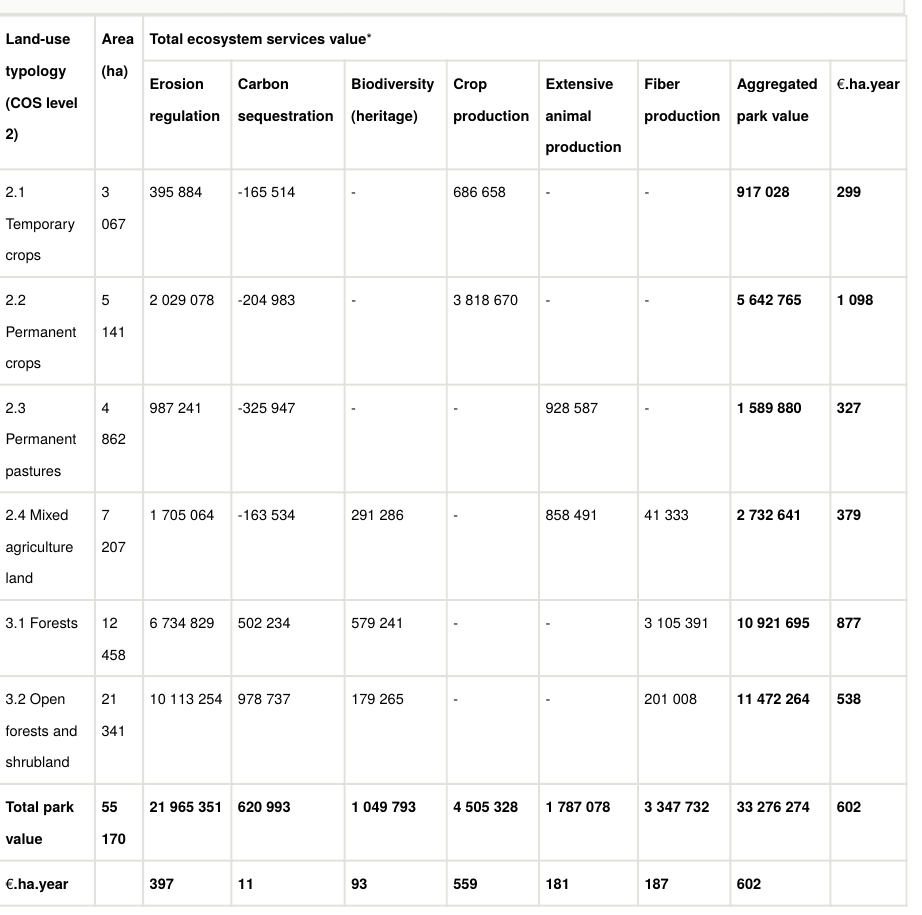
Table 4. Aggregated park economic value (€.year ) and breakdown per ecosystem typology. -1